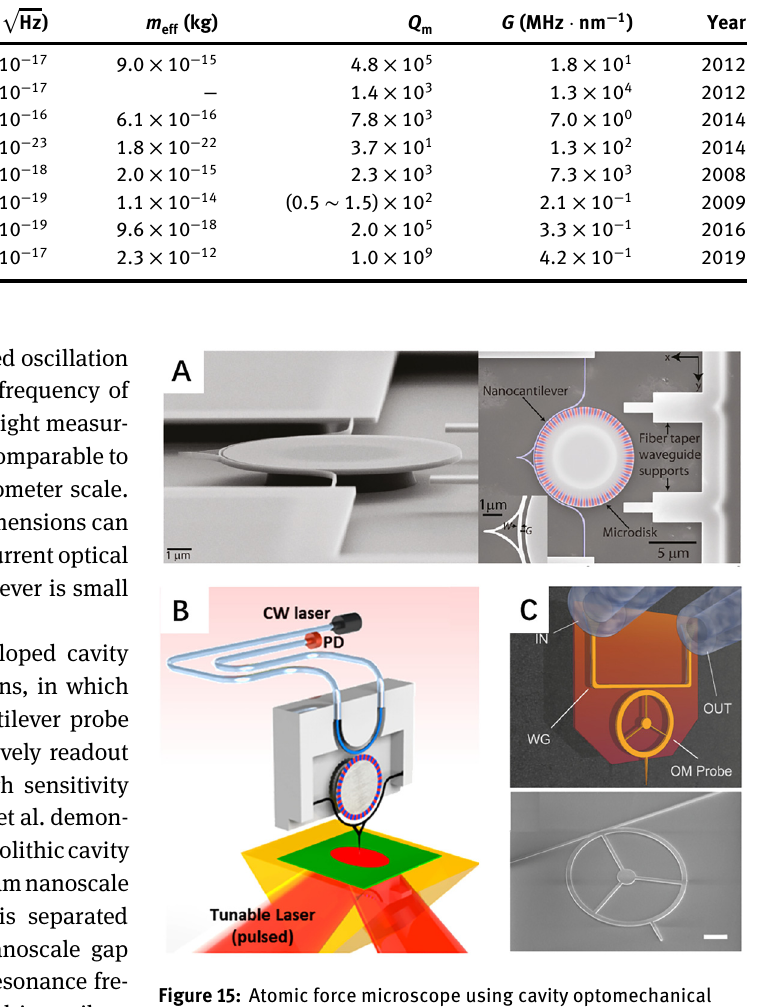
Figure 15: Atomic force microscope using cavity optomechanical systems. (A) Integrated silicon microcatileter probe which is optomechanically transduced using a microdisk [36], (B) photonic transducer photothermal induced resonance: a fiber-pigtailed, integrated transducer leverages cavity optomechanics to measure motion of a nanoscale probe, radically reducing the noise and increasing the measurement bandwidth for capturing the sample’s fast thermalization dynamics induced by laser pulses [37]. (C) Top: optomechanical probe with resonance frequency larger than 100 MHz, which couples light through a waveguide (WG) and two fiber grating couplers (IN and OUT). Bottom: SEM micrograph of the optomechanical probe, used in